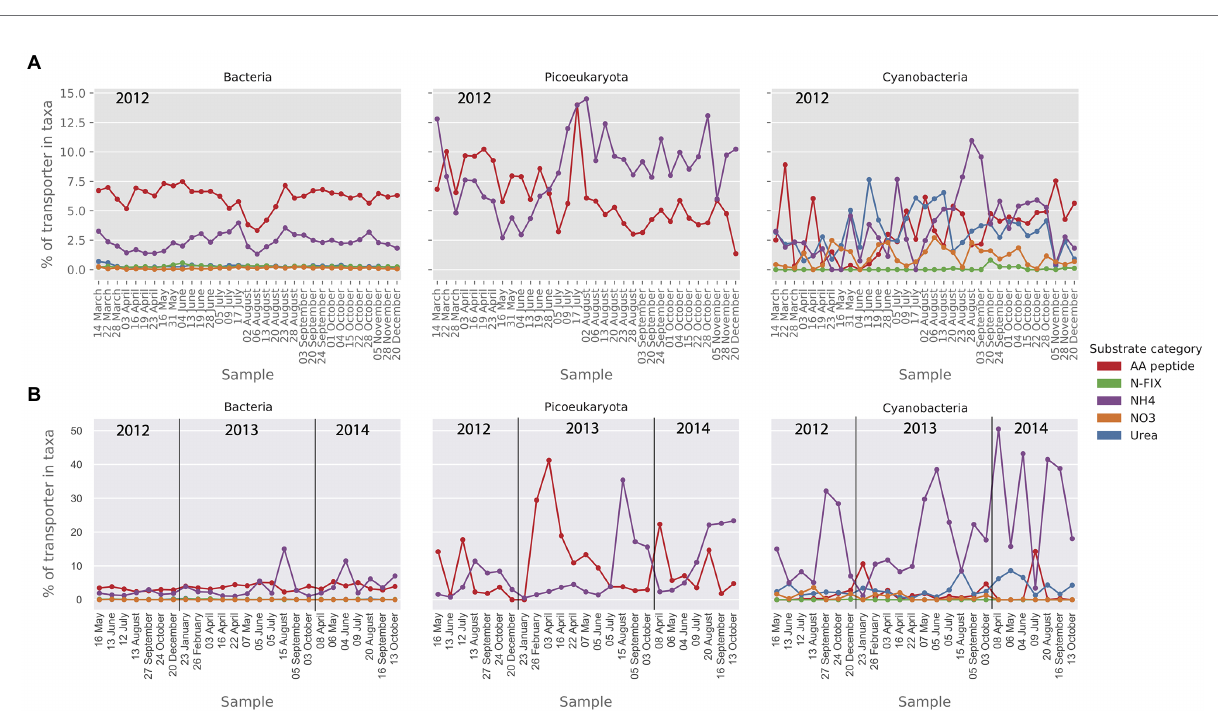
FIGURE 8 | Relative abundance (MG) and activity profiles (MT) of selected mineral nutrient transporters within category nitrogen substrates in (A) the metagenomic dataset and (B) the metatranscriptomic dataset. Gene abundances and transcripts are shown relative to the total of the transporters within each taxonomic group. Only transporters that make up at least 1% of the relative transporter abundance/activity in one or more samples are shown here.